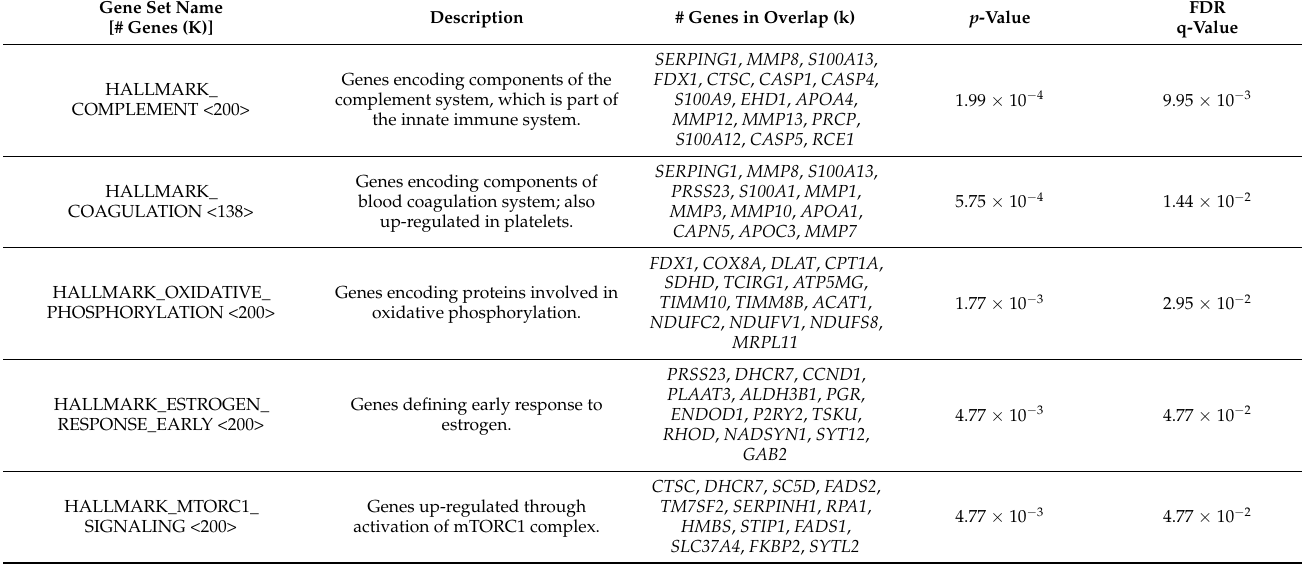
Table 2. CNV loss sites and overlap genes of FE25L (p124) compared to FE25 (p20) cells (all at